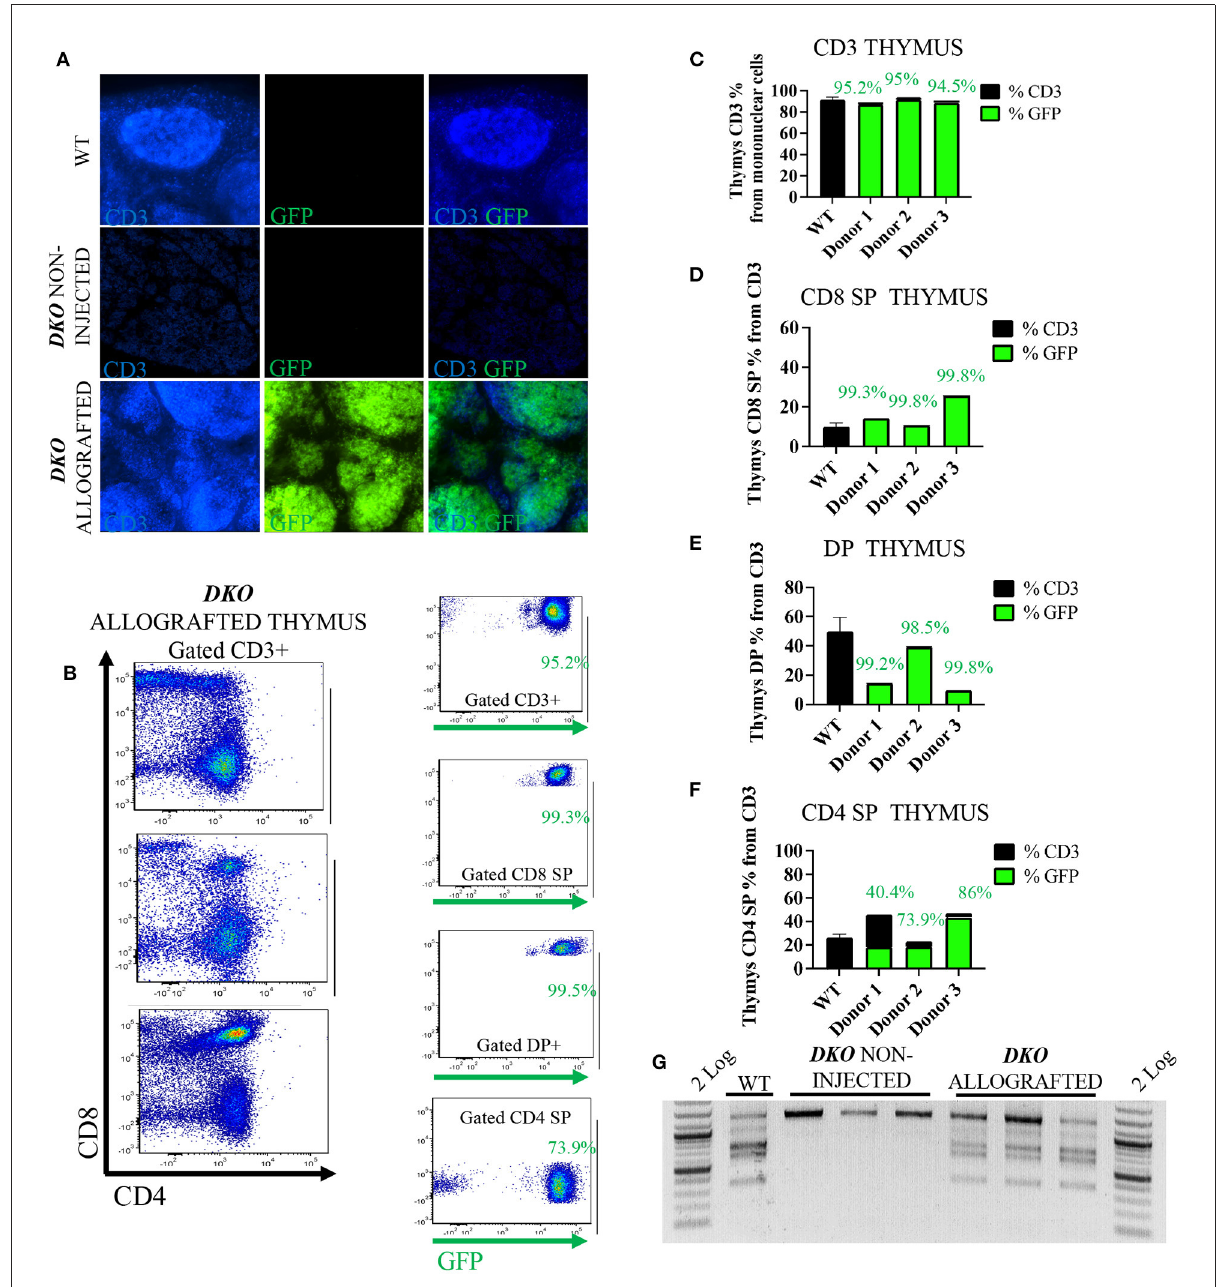
FIGURE3 In utero allogeneic transplantation of pH2B-eGFP fetal liver cells restored T -cells and TCR- β recombination in the thymus of 1-week-old DKO pigs. (A) Immunofluorescence staining (20x magnification) for CD3 (blue), and pH2B-eGFP (GFP-green). Wild-type thymus contains CD3 positive cells, but not pH2B-eGFP (GFP) positive cells. Thymus of non-injected DKO pigs is negative for both CD3 and pH2B-eGFP cells. The thymus of allografted DKO pigs contains CD3 cells, all overlapping with pH2B-GFP positive cells. (B) flow cytometry plots from the thymi of three allografted DKO pigs, showing expression of CD4 and CD8 (gated on CD3 + cells). Also shown are representative plots of GFP + CD3 + , CD3 + CD8 + , CD3 + CD4 + CD8 + (DP) and CD3 + CD4 + cells. (C–F) Histogram showing thymic percentage and chimerism of CD3 + cells (C) , CD3 + CD8 + cells (D) , DP cells (E) and CD3 + CD4 + cells (F) from thymi of all three DKO allografted pigs, while a wild type ( n = 3) serves as positive control. The green histogram represents the levels of pH2B-eGFP chimerism, indicating the percentage of allograft donor-origin cells from the respective population. (G) PCR assay for the identification of rearranged TCR - β locus from thymus gDNA. Non-injected DKO pig thymus served as a negative control and a wild type as the positive control. All three allografted pig thymi display rearranged TCR- β